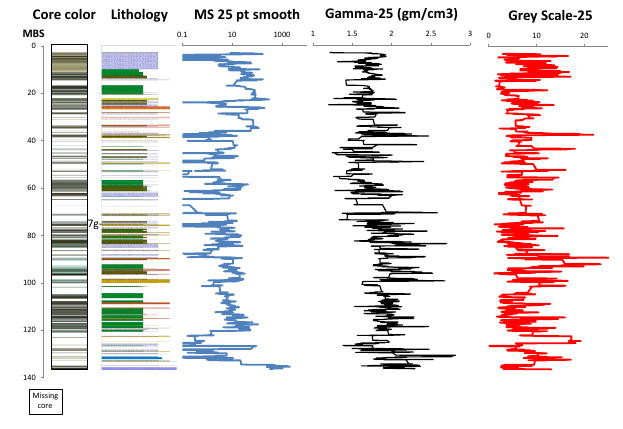
Figure 12. Summary stratigraphy of composite core HSPDP- MAG14-1A + 1C (basal portion of 1C core below 125m only), from the Lake Magadi drilling area, southern Kenyan Rift Val- ley, based on initial core description results. Columns from left to right: core color stratigraphy; lithologic log; see Fig. 5 for the key to lithologies used in all cores illustrated; composite of magnetic susceptibility (MS) log data (25-point running mean smooth) from LacCore Geotek © XYZ point sensor data; composite of induced gamma density log data (25-point running mean smooth, spurious values <1.2gmcm − 3 removed); composite of spectrophotometric grey-scale log data (25-point running mean smooth). All data col- lection, instrumentation, and parameters as in Fig. 5.